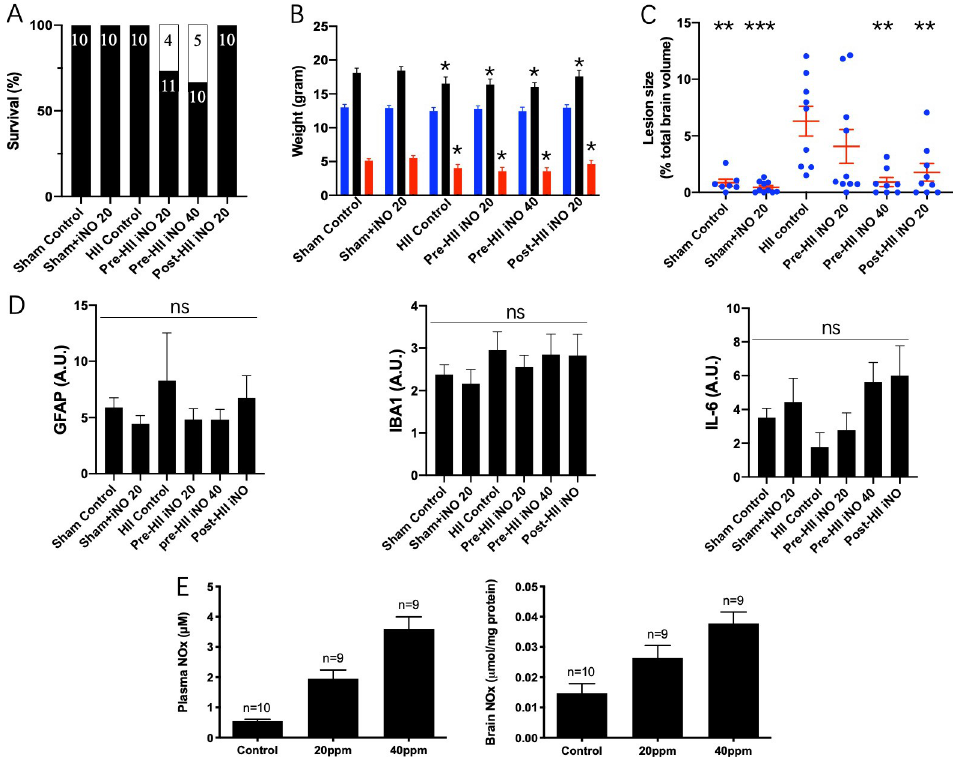
Fig 2. Effects of iNO on neonatal HII. A) Effects of iNO and HII on survival. pre-HII iNO at 20 and 40 ppm resulted in deaths. B) Effects of iNO and HII on weight (survived animals only). Blue represents baseline weight at P7, black represents weight at P10, red represents weight gained from P7 to P10 ( � p < 0.05 compared to Shams; One-way ANOVA). C) MRI analysis of infarct size at P10 ( �� p < 0.01, ��� p < 0.001 vs HII control; One-way ANOVA). D) IHC analysis of brain slices at P10. Glial fibrillary acidic protein (GFAP) (left), ionized calcium binding adapter molecule 1 (IBA1) (middle), interleukin-6 (IL-6) (right). E) iNO increased NOx in plasma (left) and brain (right).